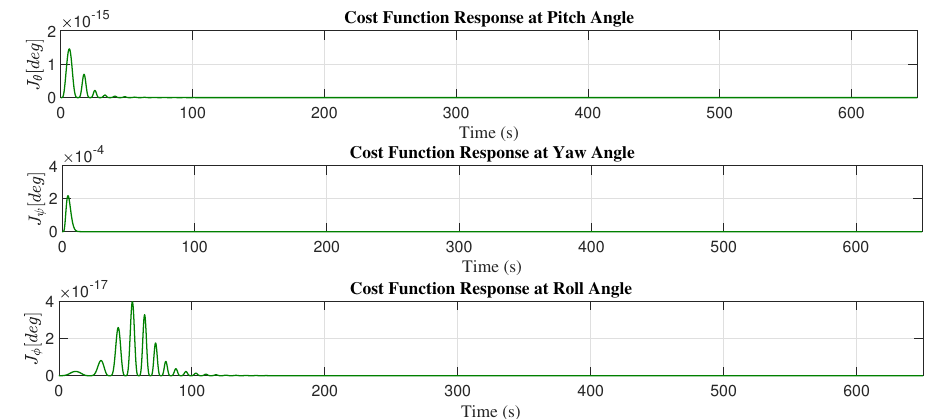
Figure 20. Minimization of J θ , ψ , φ with MIT rule with twisting (MIT-Twisting).